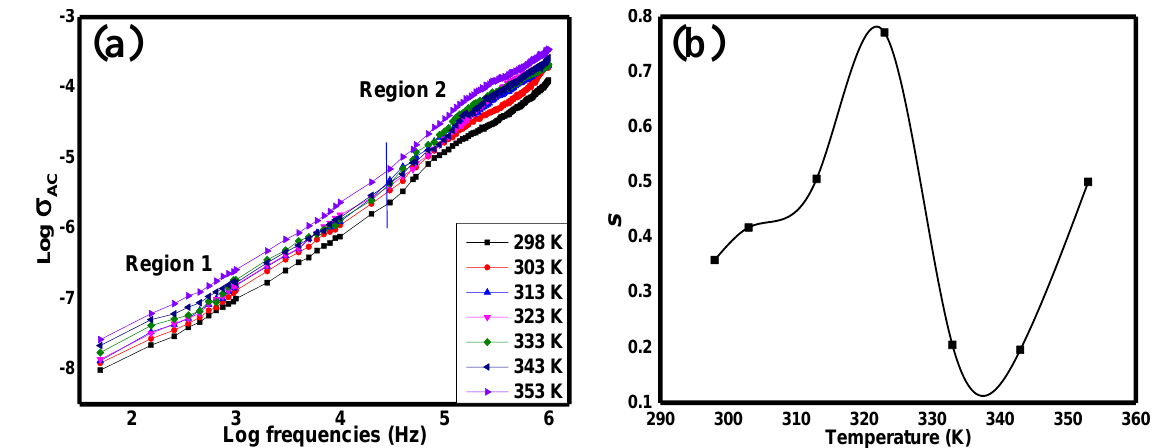
Figure 8. ( a ) AC conductivity plot against frequencies and ( b ) power-law exponent variation with various temperatures.